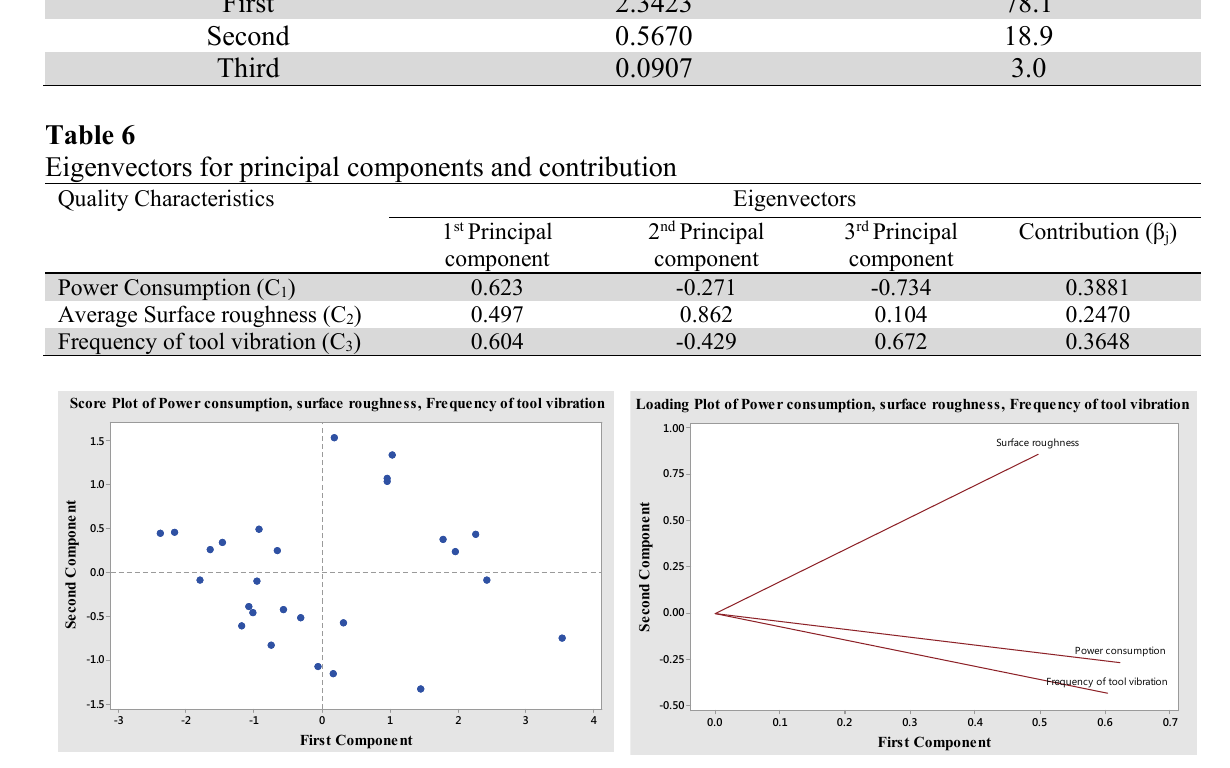
Fig. 4. Score Plot of performance characteristics Fig. 5. Loading Plot of performance characteristics